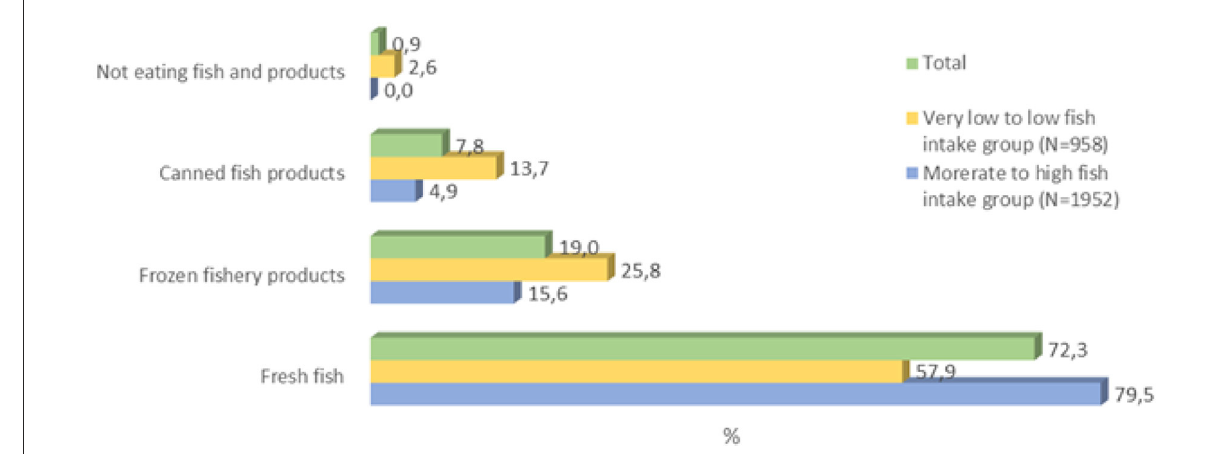
FIGURE1 The proportion of fishery products consumption among groups regarding recommended fish intake ( N =